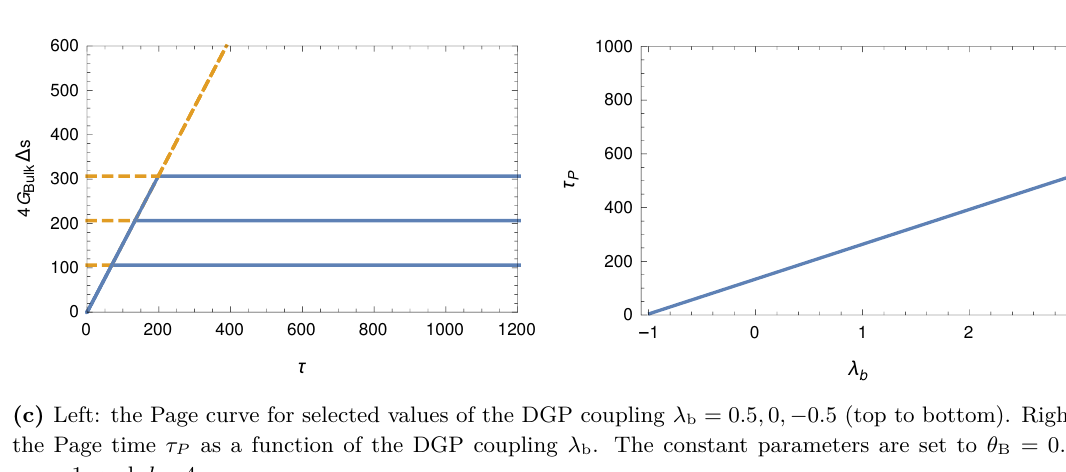
(b) Left: the Page curve for selected brane angles θ B = 0 . 07 , 0 . 10 , 0 . 15 (top to bottom). Right: the Page time τ P as a function of the brane angle θ B . The constant parameters are set to λ b = 0 , χ Σ = 1 , and d = 4 .